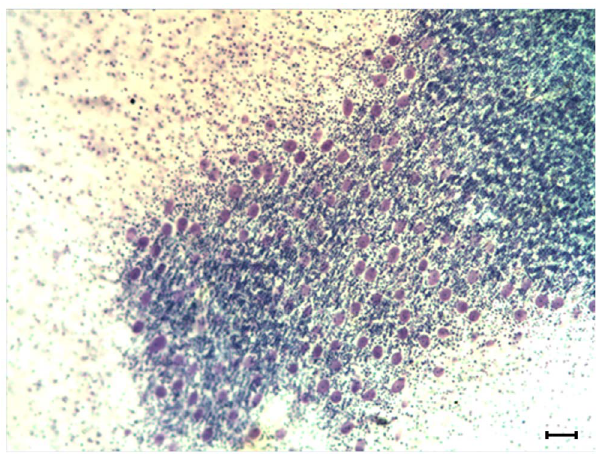
Figure 7. Photomicrograph of Transverse Section. This photo- micrograph is an illustrative example of the arrangement of PCs on a transverse section. The PCs (purple) go out of focus to the left as the PC layer curves through the depth of the tissue section. The granule cell layer (blue) is visible below the PC layer, the molecular layer surrounds the PC layer (seen here as sparsely stained space), and the white matter tract is out of view to the right. Nissl-stained section from the celloidin collection used in this study, reference bar=100 m m.